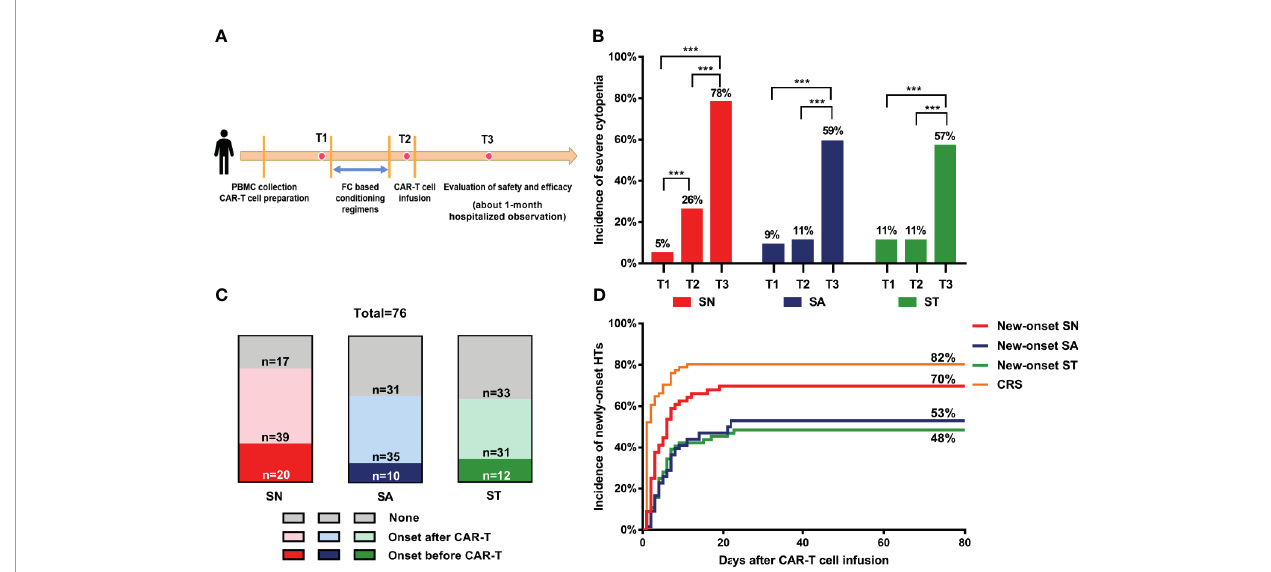
FIGURE 1 | Incidence of severe cytopenia before and after CAR-T cell infusion. (A) Clinical protocol of CAR-T cell therapy includes lymphocyte collection, lymphodepleting chemotherapy, CAR-T cell infusion, and evaluation of safety and ef fi cacy. (B) Percentage of severe cytopenia changes after lymphodepletion and CAR-T cell infusion. Two-sided P value was determined via Pearson Chi-square test (Bofferoni adjusted). (C) Proportion of severe cytopenia onset before and after CAR-T cell infusion. (D) Cumulative incidence of new-onset severe cytopenia and CRS. T1: before lymphodepletion; T2: interval between the end of chemotherapy and CAR-T cell infusion; T3: after CAR-T cell infusion. ***P < 0.001. CRS, cytokine release syndrome; PBMC, peripheral blood mononuclear cell; SN, severe neutropenia; SA, severe anemia; ST, severe